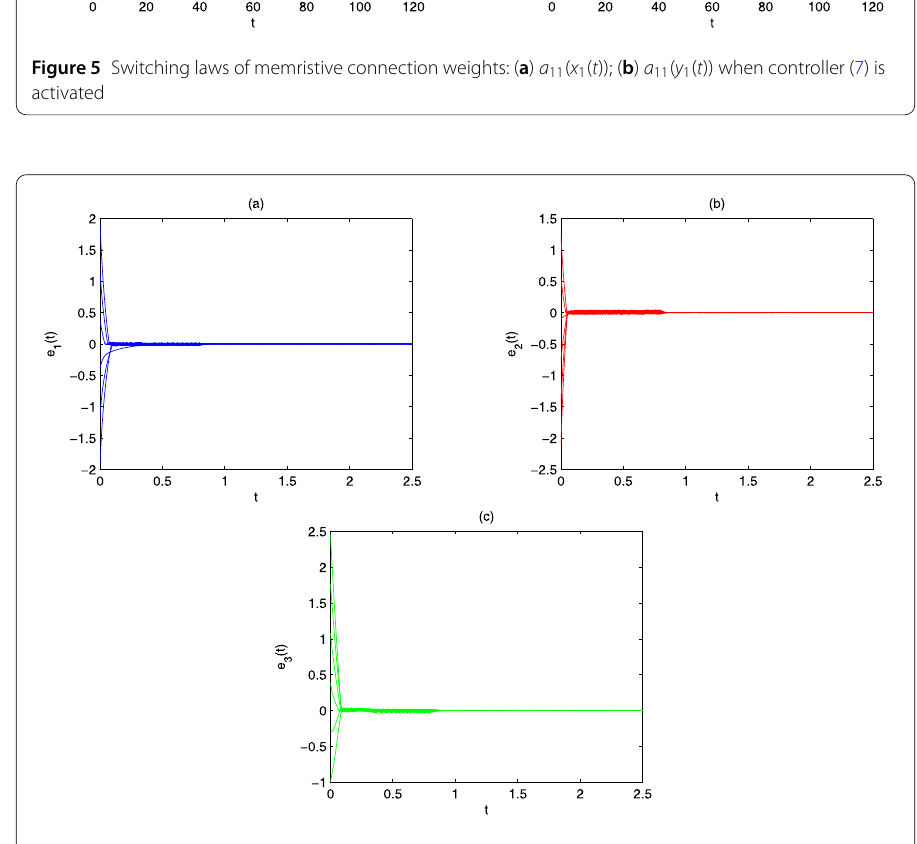
Figure 6 Time evolution of synchronization errors e 1 ( t ), e 2 ( t ), e 3 ( t ) with six random initial values when controller (7) is